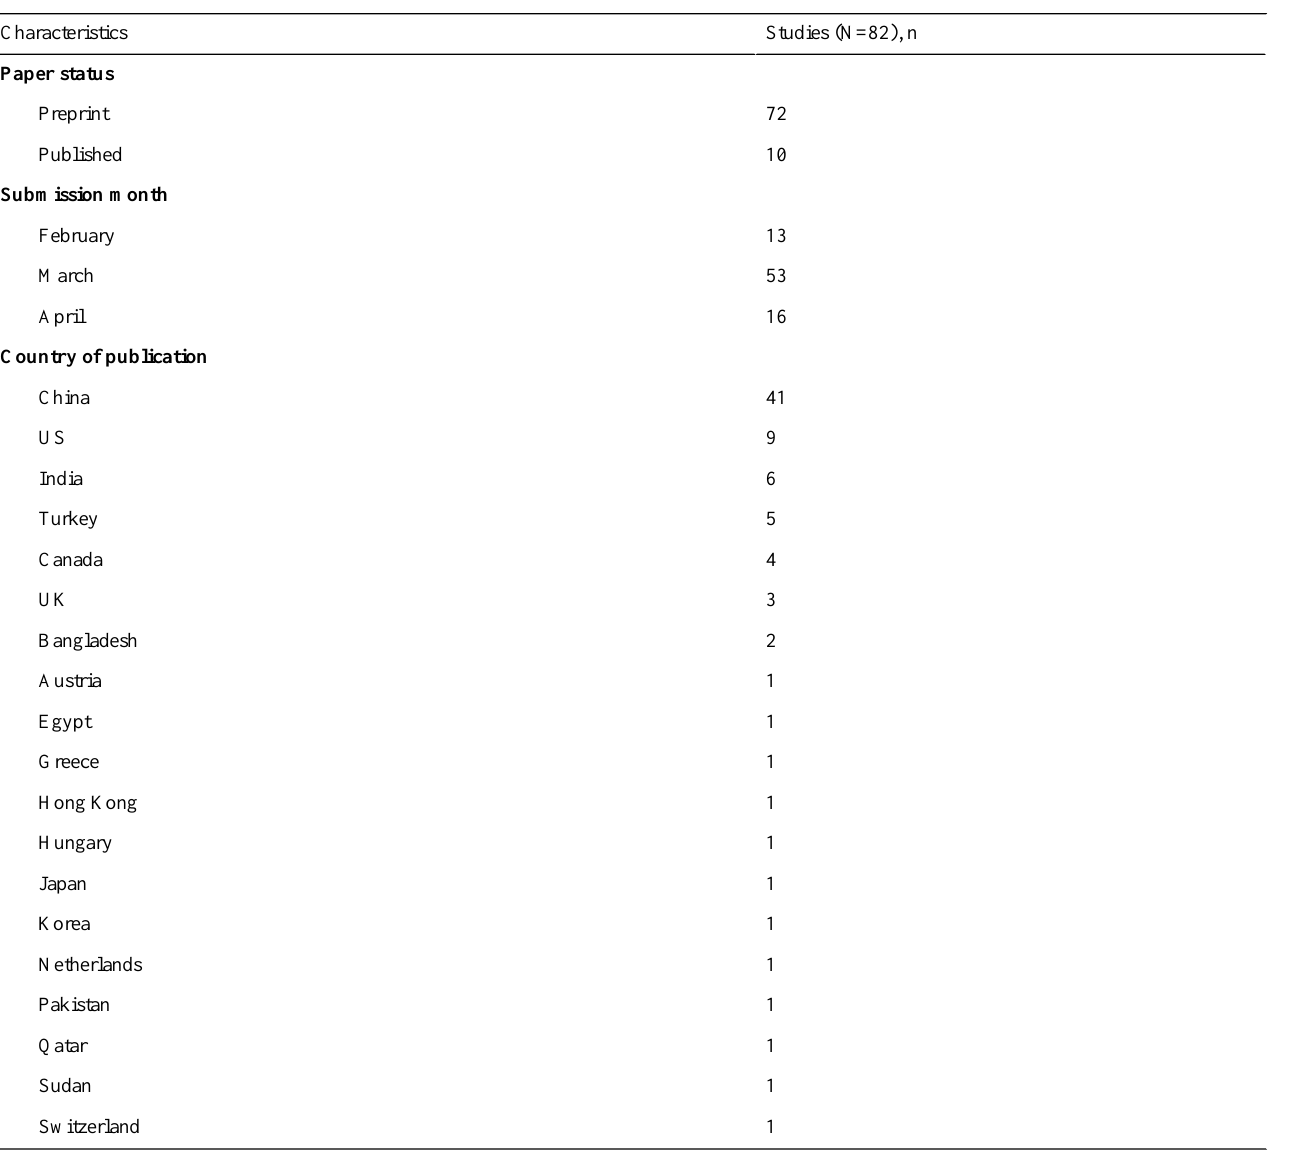
Table 1. Characteristics of the included